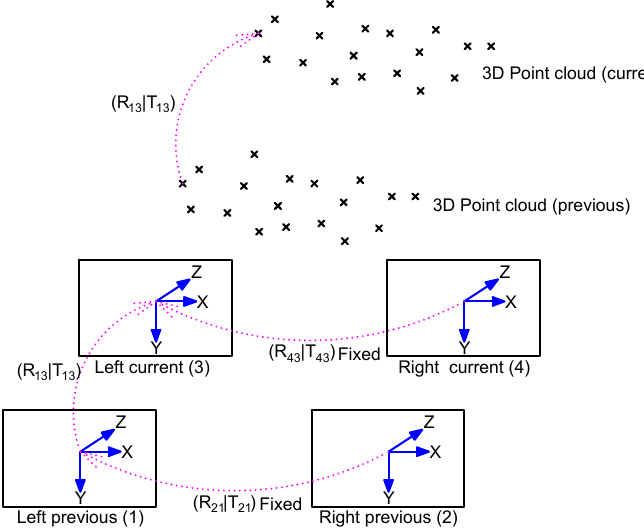
Figure 9. Image quadruplet: the current (left and right) and previous (left and right) frames are used to compute two 3D point clouds. The transformation, [ R 13 | T 13 ] , between the two points clouds is equal to the relative motion between the two camera